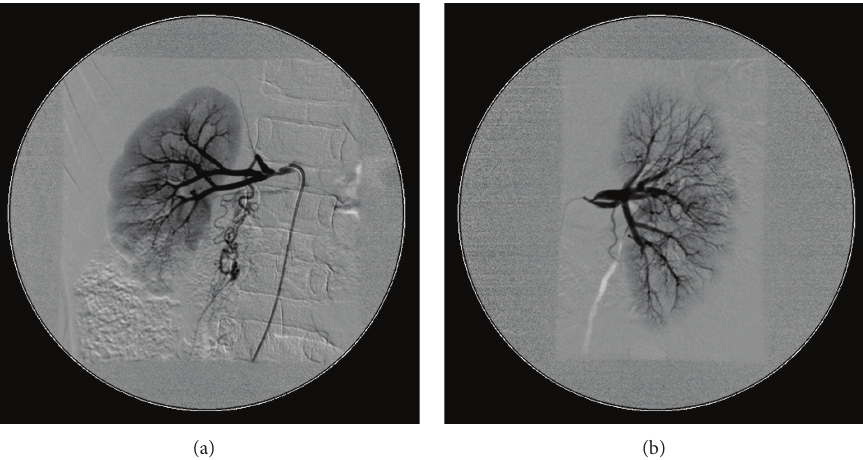
Figure 3: Angiography demonstrating severe renal artery stenosis and multiple intrarenal vessel narrowing and collateral blood vessels branching away from the renal artery.